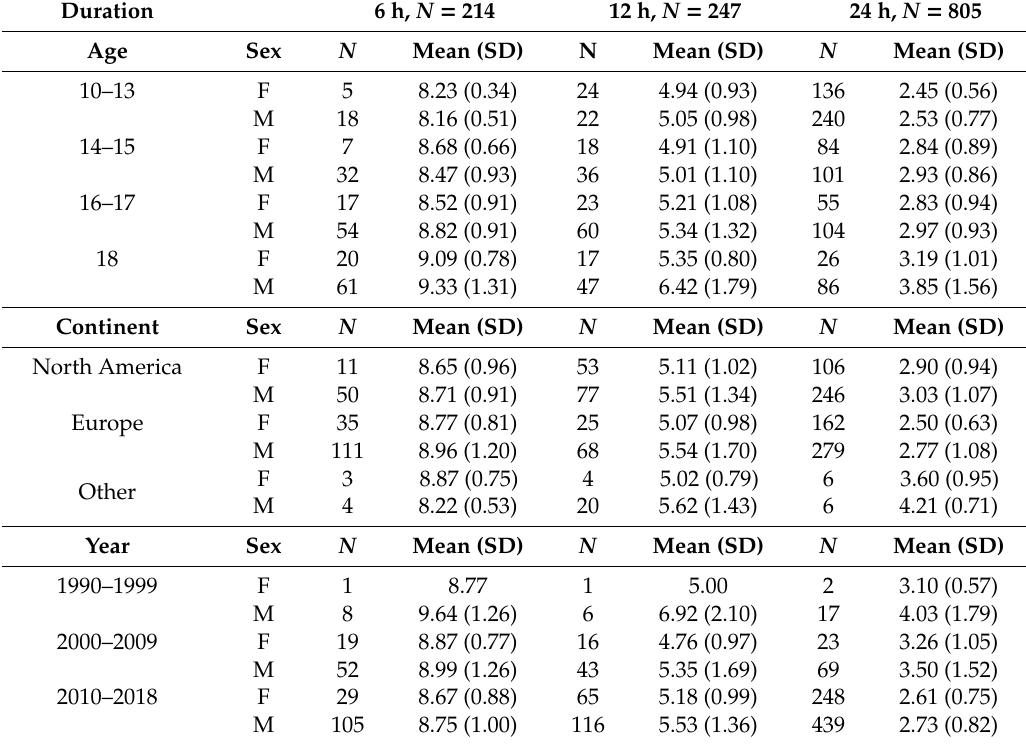
Table 2. Mean ultra-endurance running speed in km / h and (SD): duration of races (6, 12 and 24 h) by sex, age, country (continent) and calendar year groups. Africa, Asia, Central-South America, Oceania, due to small sample size, were combined into “Other” group.